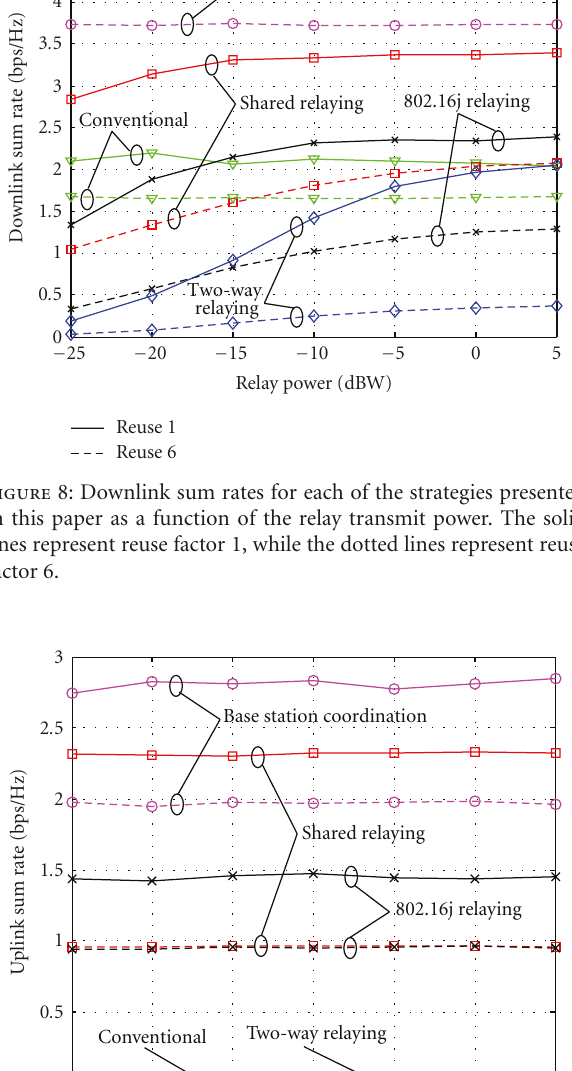
for frequency reuse factor 6 because the curves are more separated in this case. At around half-way between the base station and shared relay (which is located at the left-most corner of the sector), direct transmission becomes more desirable than relaying. By adapting between these two cases based on the position of the mobile station, the downlink